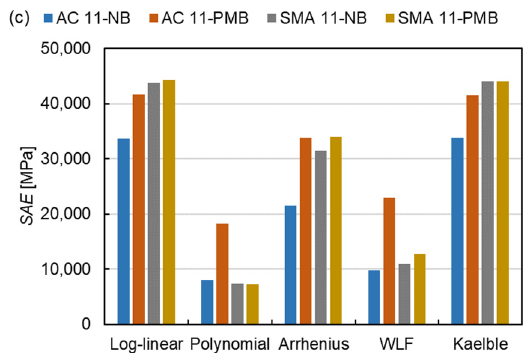
Figure 10. SAE of all fitting procedures: ( a ) SLS model, ( b ) GLS model and ( c ) CAM model.